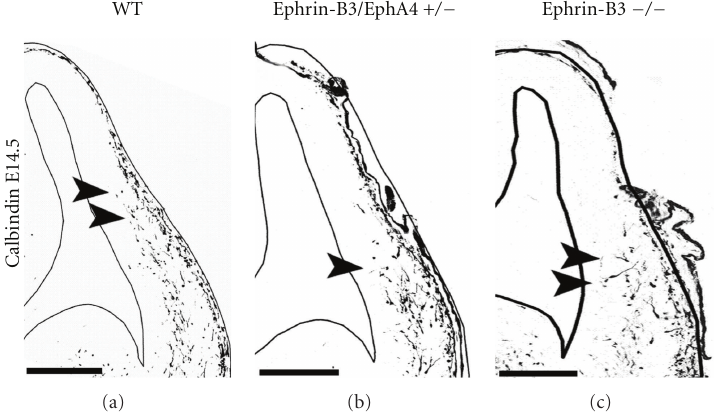
Figure 4: Alterations in the Eph/ephrin system cause a delayed migration of cortical interneurons in vivo. Analysing the calbindin-(CB-) positive interneurons in the cortex of E14.5 embryos revealed a delayed migration of interneurons in hetero- and homozygotic ephrin- B3/EphA4 knockout mice compared to the wild-type (WT) littermates. Arrow heads indicate the front of migrating interneurons. Scale bar: 100 μ